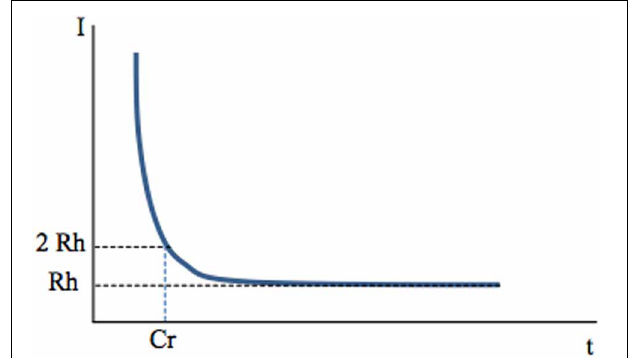
FIGURE 1 | Chronaxy. Deep-brain high-frequency stimulation is applied through an extracellular stimulating electrode. Stimulation usually consists of 60–400 μ s pulses applied at a frequency of 100–130Hz. It activates one or several neuronal elements close to the stimulating electrode: somato-dendritic trees, axons, axon terminals. This depends on stimulation parameters, since each of these elements has a specific chronaxy (Ranck, 1975) which determines whether they are activated by a given stimulation. A single, short-duration, extracellular stimulating pulse preferentially activates axons The link between the intensity of stimulation (Y axis) and the minimal duration of this stimulation (pulse width, X axis) needed to activate a given element (muscle fiber or neuron, soma or axon of a neuron) is hyperbolic and described by the Weiss law: I = Rh ( Cr / t + 1 ) . When the current intensity of a pulse is decreased, its duration (pulse width) must be increased to produce constant effects i.e., activate the given neuronal element. The asymptote to the X axis defines the rheobase (Rh) . It corresponds to the minimal current intensity needed to activate an element (muscular or neuronal). If applied at an intensity lower than rheobase, the stimulus will never activate a given element, whatever its duration ( t ). The minimum duration required for a constant electric current of twice the rheobase to excite tissue is the Chronaxy (Cr) . When I = 2 Rh , t = Cr The concepts of “chronaxie” and “rheobase” were introduced in 1909 by the French physiologist L. Lapicque. The root word “rheo” means current and the root word “chron” means time. The chronaxy is used to quantify the excitability of an element. The element is more excitable when its chronaxy is short. Chronaxies of the different elements of the nervous system differ by a factor of 5 to 300. Large myelinated axons of the central nervous system have a chronaxy of 30–300 μ s and around 500 μ s for non-myelinated axons, whereas that of somas and dendrites is around 1–10ms (Ranck, 1975). In the cat visual cortex, Nowak and Bullier (1998) found similar results with a chronaxy of around 270 μ s for axons of the subcortical white matter and of 15ms for somas in the cortex. Therefore, a stimulating pulse of 60–400 μ s duration preferentially activates axons. Larger axons have a lower threshold of activation because the intracellular resistance to longitudinal ionic flux is low as a result of the higher percentage of ions that carry the current per length unit. Therefore, for a given current applied, the large axons are those most easily